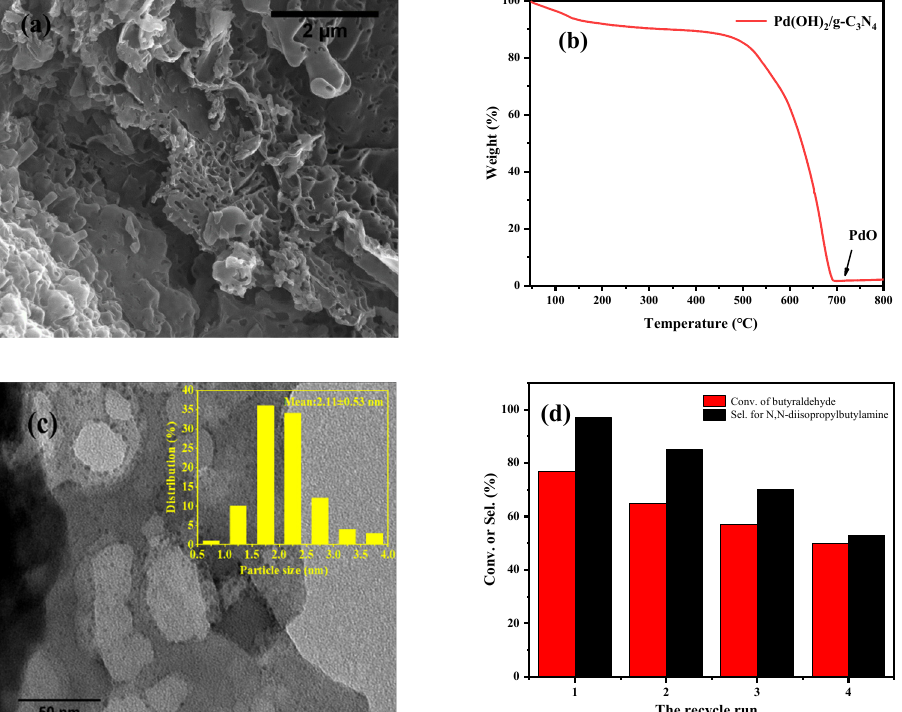
Figure 4. SEM ( a ) and TEM ( c ) images of Pd(OH) 2 /g-C 3 N 4 , ( b ) Thermogravimetric plots for Pd(OH) 2 /g-C 3 N 4 and the size distribution of Pd species on Pd(OH) 2 /g-C 3 N 4 . ( d ) Reuse of 1.1 wt% Pd(OH) 2 /g-C 3 N 4 catalyst at same conditions.